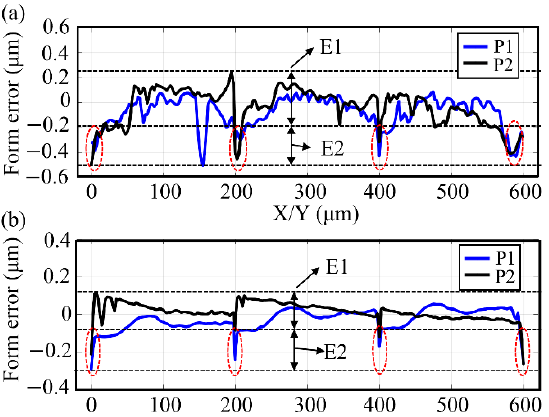
Figure 9. Form error between the designed profile and the measured profile: ( a ) P1, P2 for the microlens array machined by CS, ( b ) P1, P2 for the microlens array machined by HFUVAS.